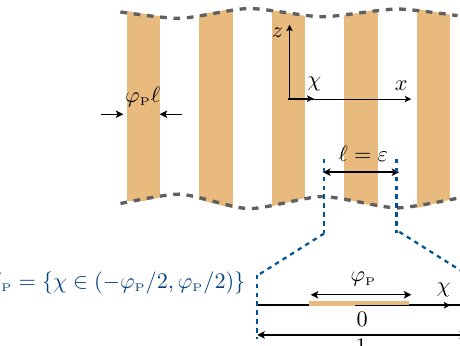
Figure A1. Homogenization in the bulk of the array. In the x = ( x , z ) coordinate, the array has a spacing (cid:96) = ε . The rescaling in the horizontal χ = x / ε one-dimensional